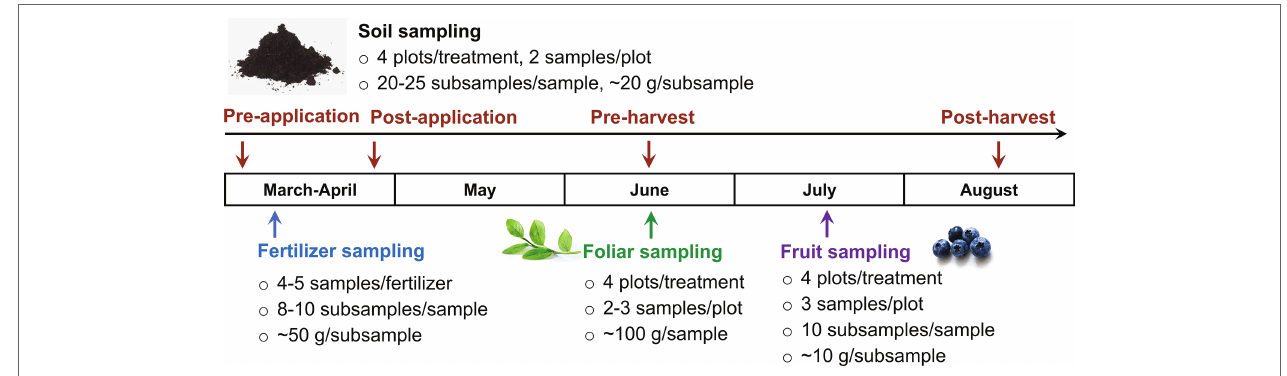
FIGURE 2 | Microbiological sample collection plan in 2017–2018 production